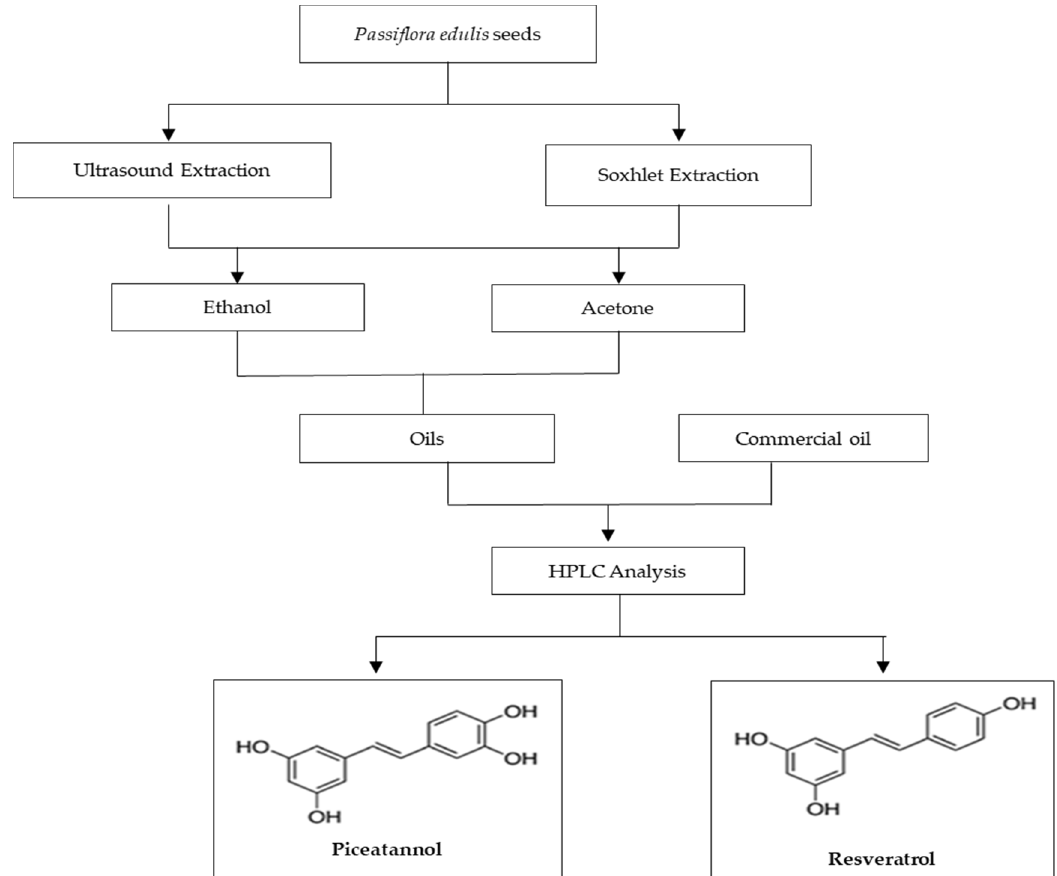
Figure 5. Flow diagram for the extraction and separation by HPLC of piceatannol and resveratrol.